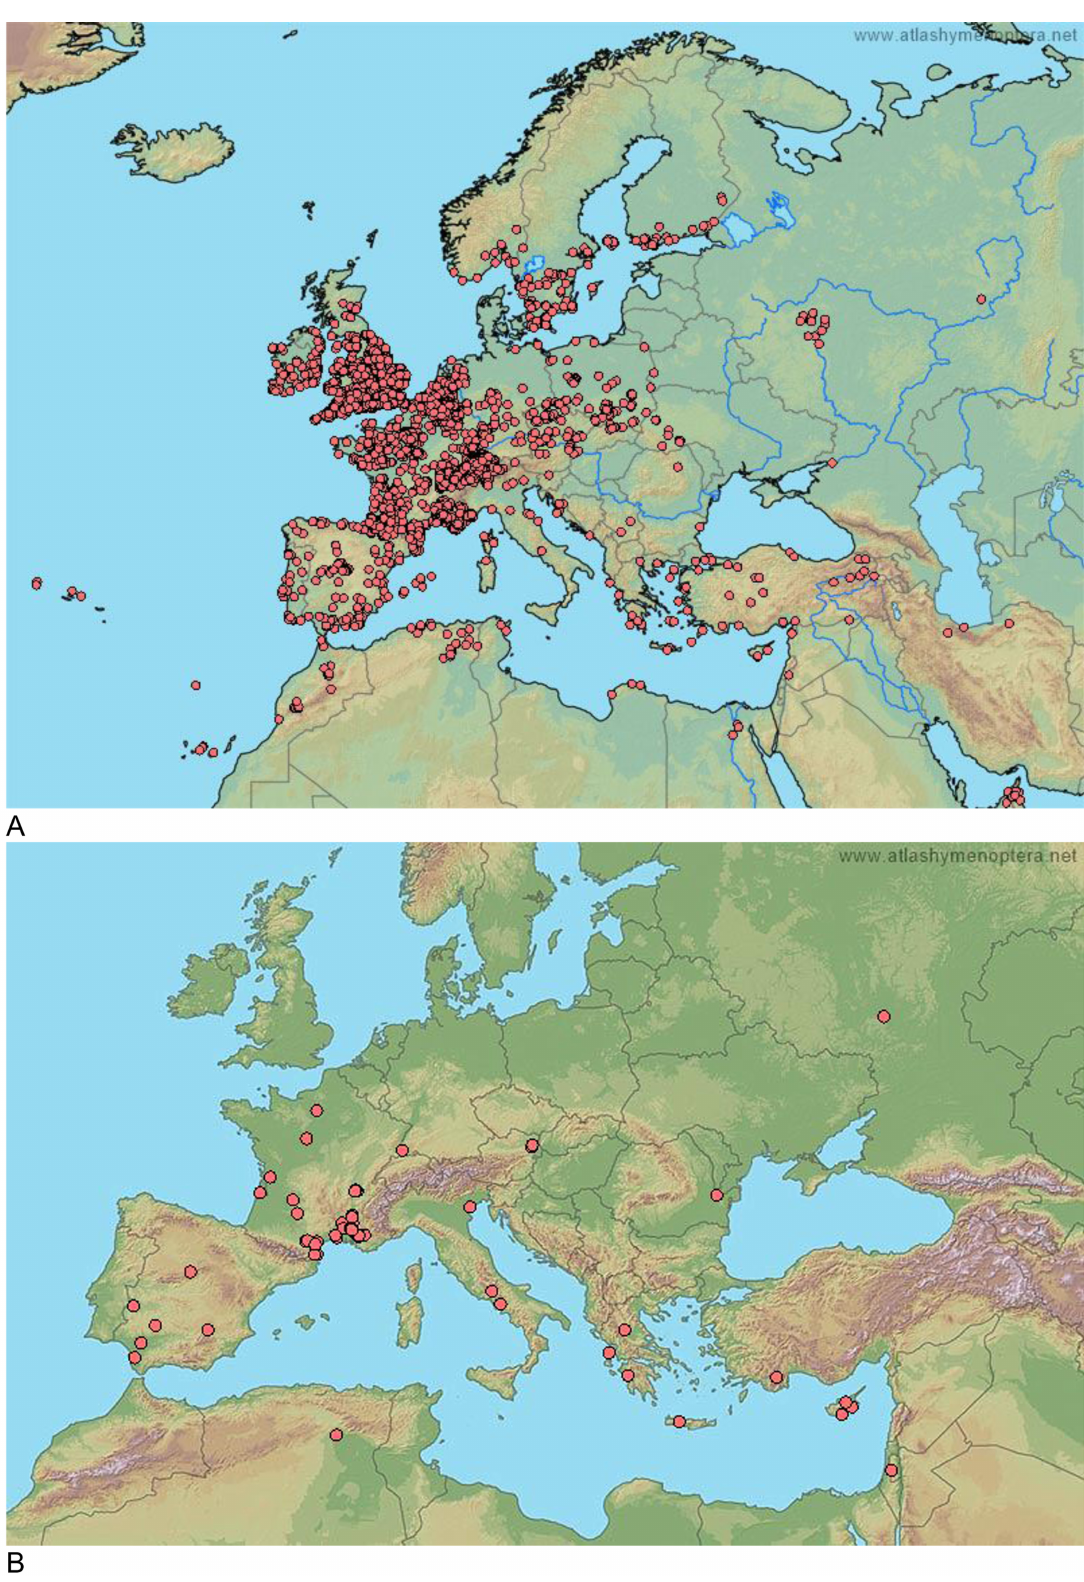
Fig. 22. Geographical distribution of the two pseudocryptic species in the Western Palaearctic. A . Lasioglossum villosulum (Kirby, 1802). B . L. medinai